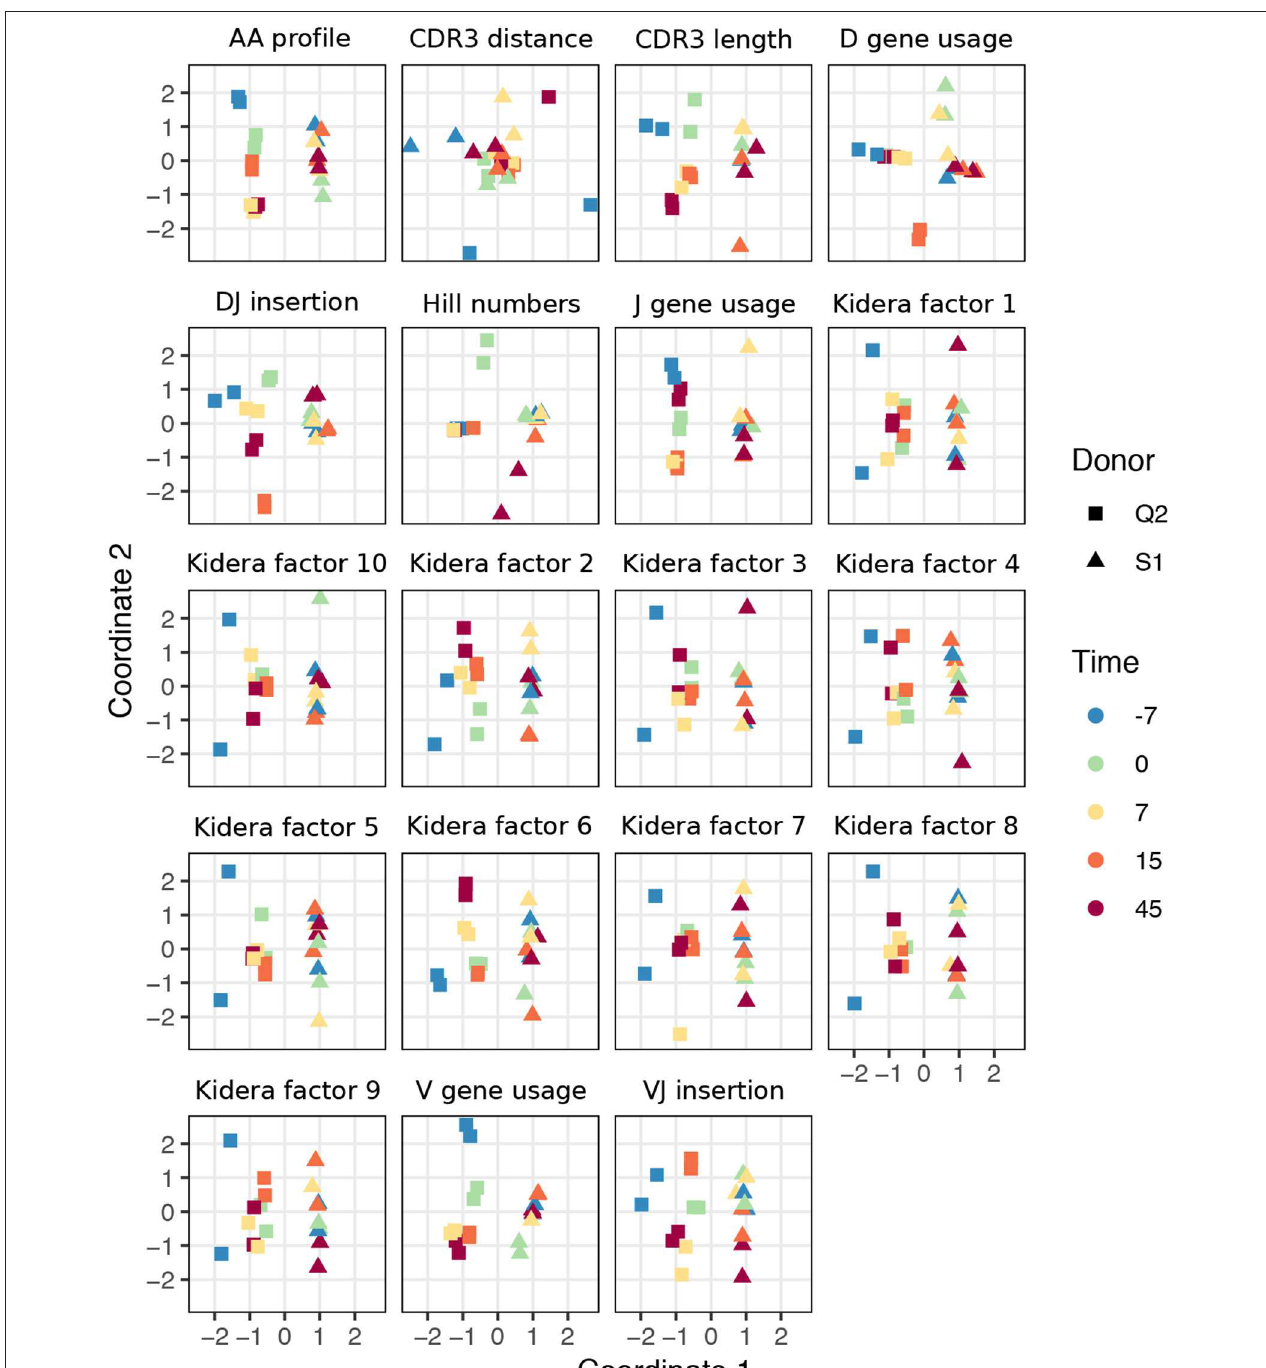
FIGURE 2 | Plots of summary divergence MDS coordinates for data from Pogorelyy et al. (32), grouped by donor and timepoint.